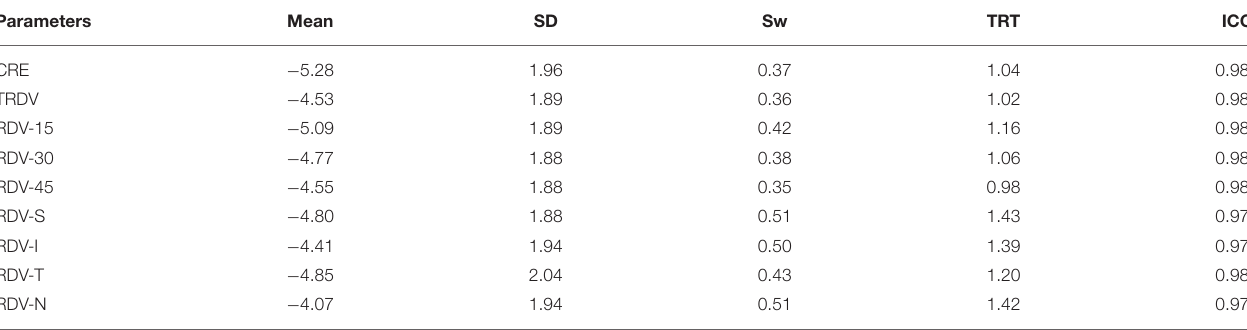
TABLE 1 | Intraobserver repeatability outcomes of central and peripheral refraction using MRT without cycloplegia.